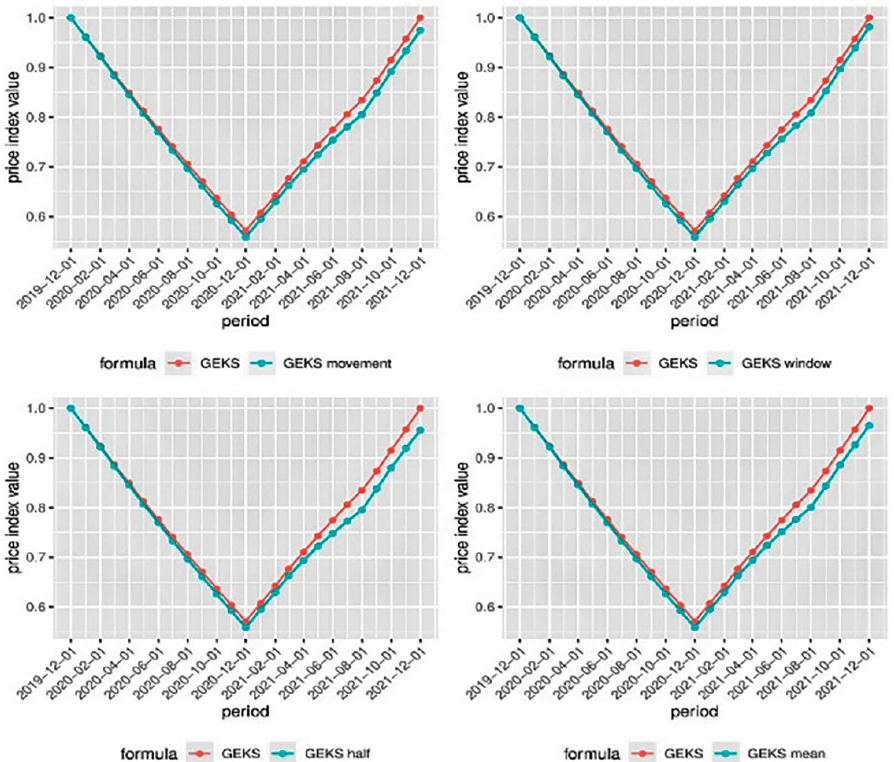
Figure 5. Comparison of selected splice GEKS indices to the full-window GEKS method for Case 2 and for d = 8 Table 3. Mean absolute distances between considered splice GEKS indices and the target full window GEKS price index (p.p): Case 1 Index: